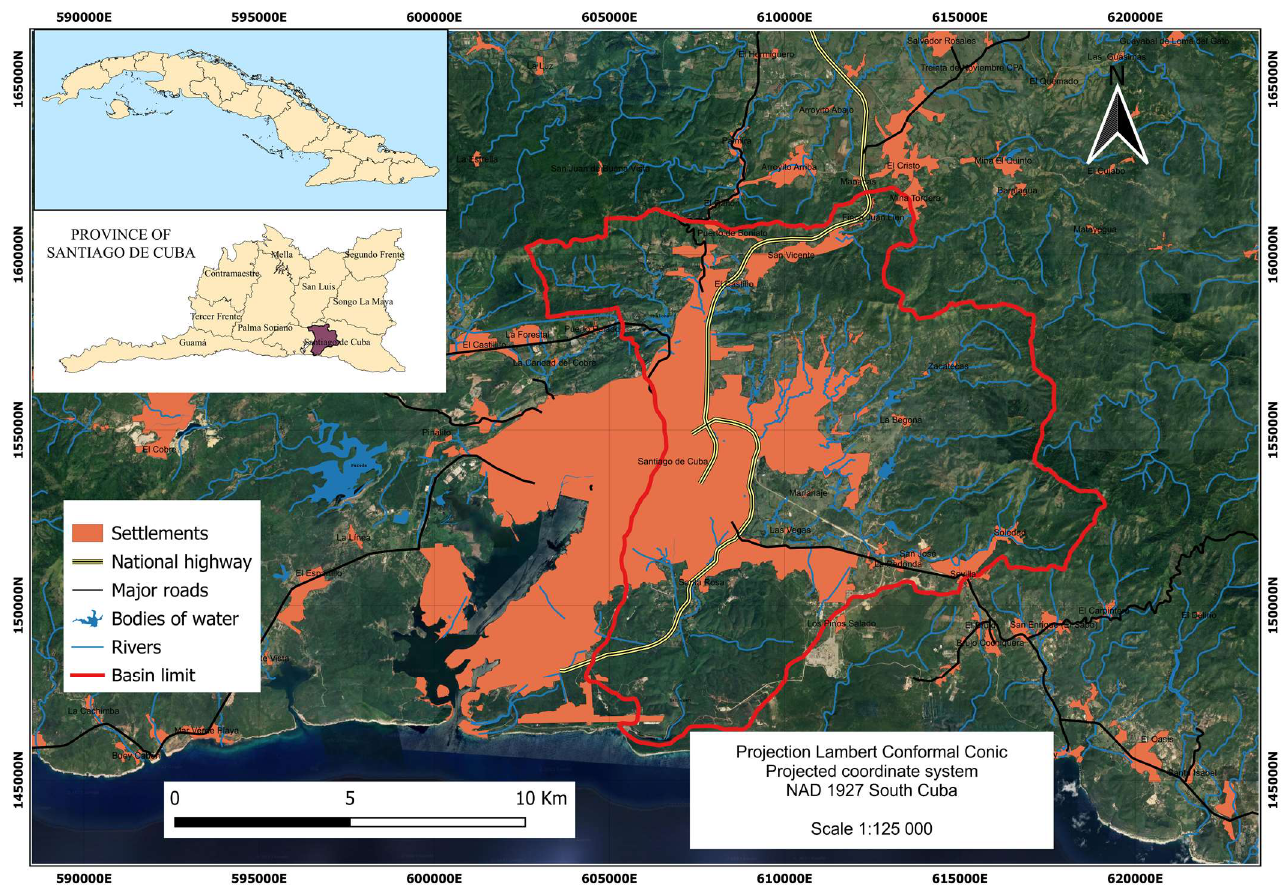
Figure 1. Location of the studied San Juan River Basin. Caption: orange represents different kinds of urban and rural settlement.